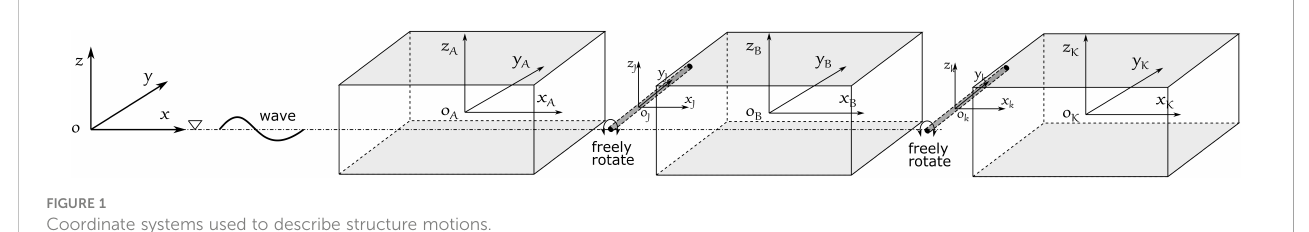
FIGURE 1 Coordinate systems used to describe structure